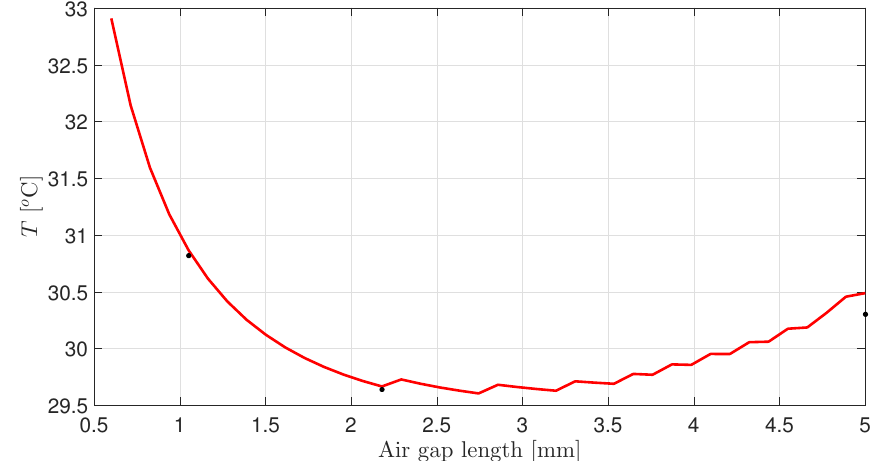
Figure 11. The PM temperature variation with the air gap